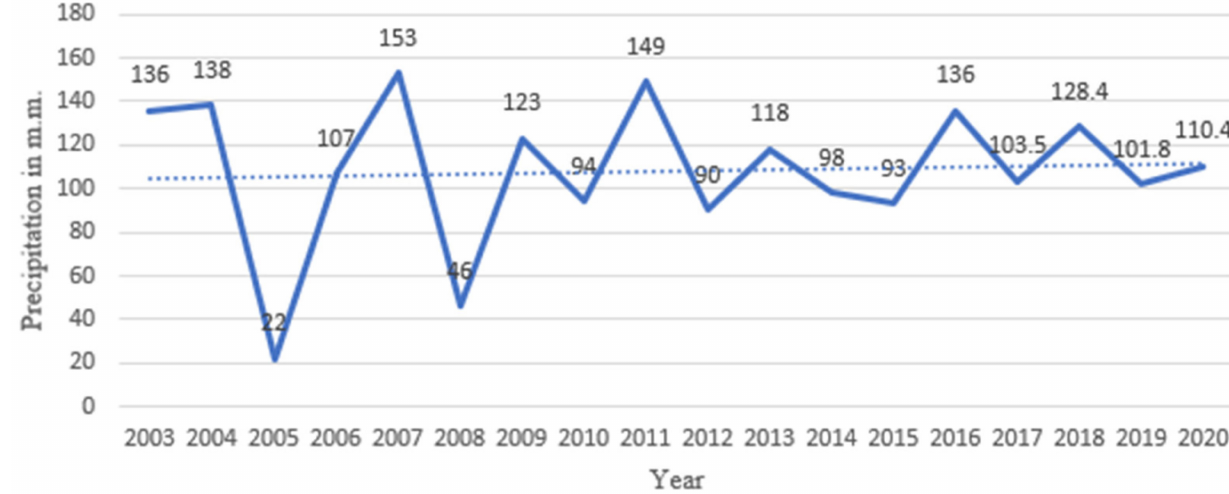
Figure A1. Observed annual daily maximum precipitation of Kushma, Parbat.